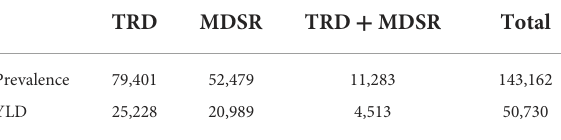
TABLE 3 Years lived with disability—global results. TRD MDSR TRD + MDSR Total